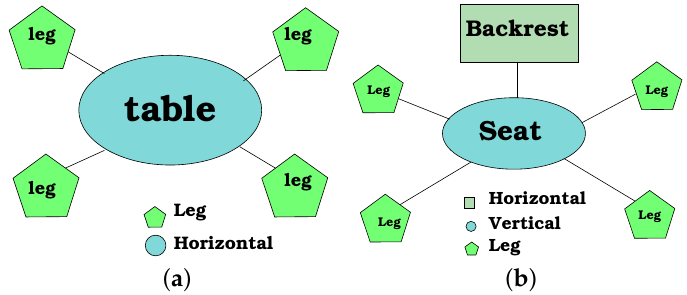
Figure 10. Example of complete graph models for: ( a ) a dinning table and ( b ) a chair; different shapes represent different types of geometric components.